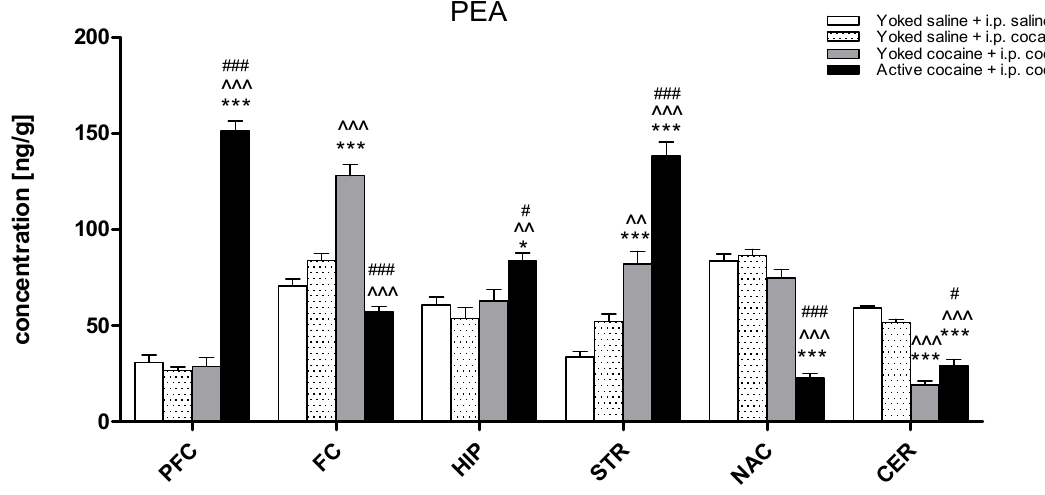
Figure 5. Levels of palmitoylethanolamide (PEA) in brain structures in rats previously self-administered cocaine (14 days) (Active cocaine) or which passively received cocaine (Yoked cocaine) or saline (Yoked saline) and underwent extinction training (10 days) and drug-induced reinstatement (10 mg/kg cocaine i.p. or saline i.p.). N = 7–8 rats/group. All data are expressed as the means ± SEM. * p < 0.05, ** p < 0.01, *** p < 0.001 vs. Yoked saline + saline i.p.; ^ p < 0.05, ^^ p < 0.01, ^^^ p < 0.001 vs. Yoked saline + cocaine i.p.; # p < 0.05, ## p < 0.01, ### p < 0.001 vs. Yoked cocaine + cocaine i.p. A description of the abbreviations has been placed under Figure 2.